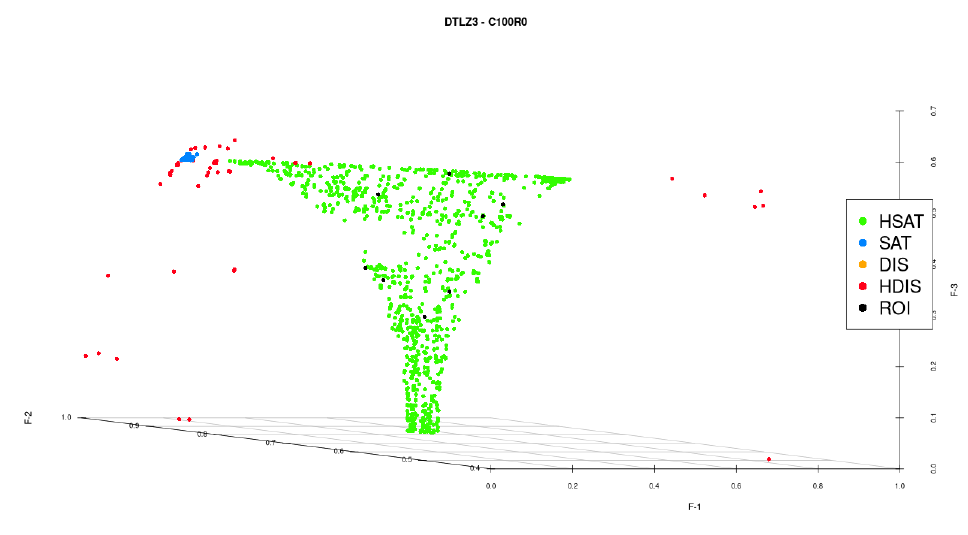
Figure 3. Non-dominated NSGA-III-P(C100R0) solutions of the DTLZ3